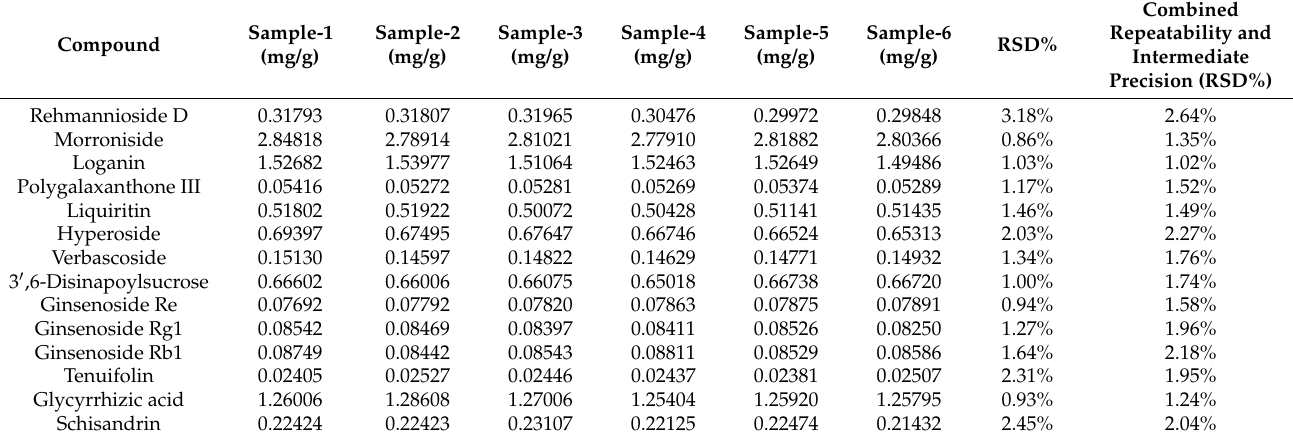
Table 5. Intermediate precision study results of 14